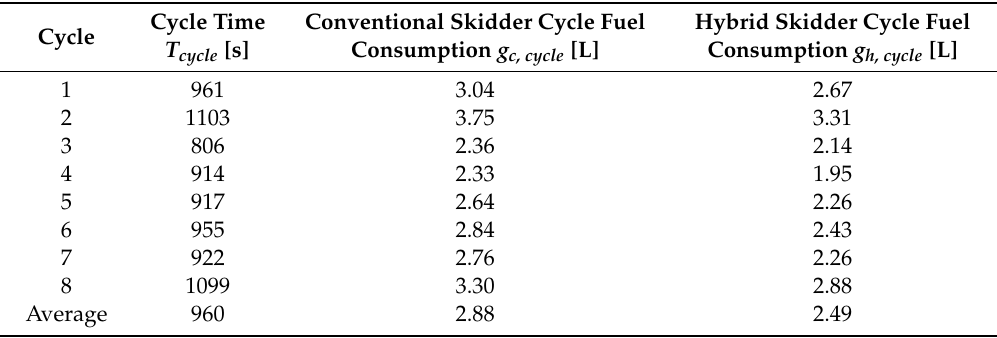
Table 10. Results for skidder’s work day.